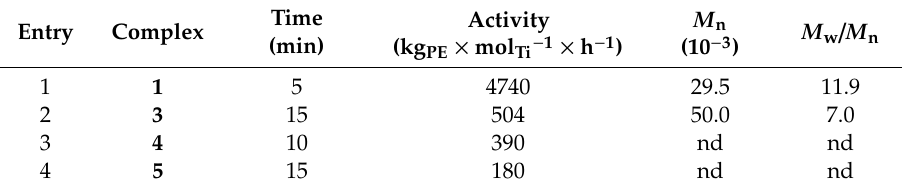
Table 2. Ethylene polymerization catalyzed by 1 , 3 , 4 and 5 / MAO systems [7].